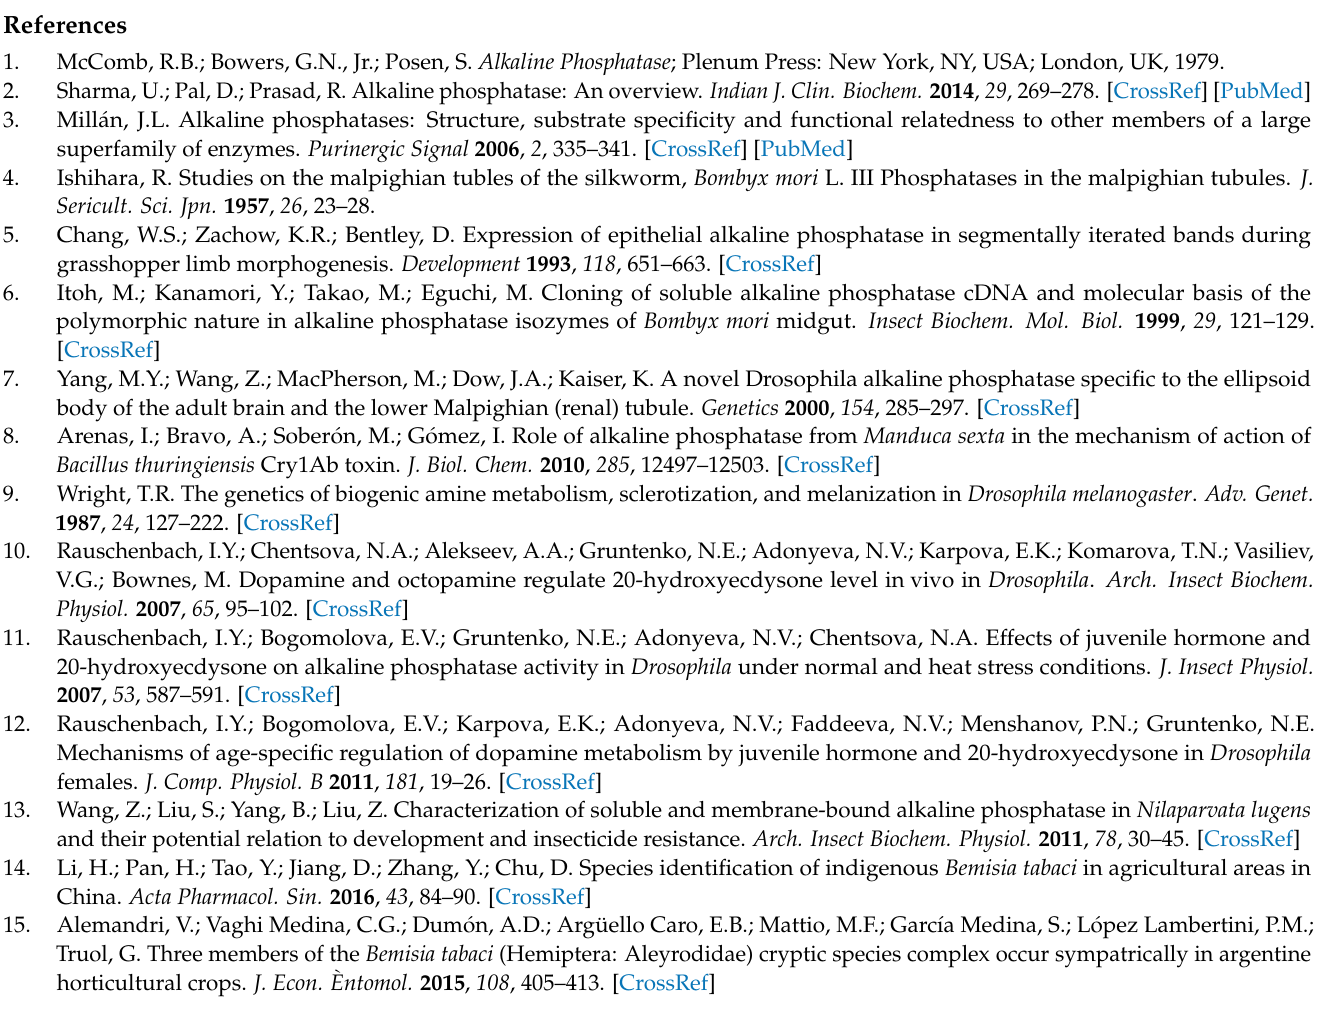
Figure S2. Multiple sequence alignments of ALP proteins from B. tabaci MEAM1 and MED based on